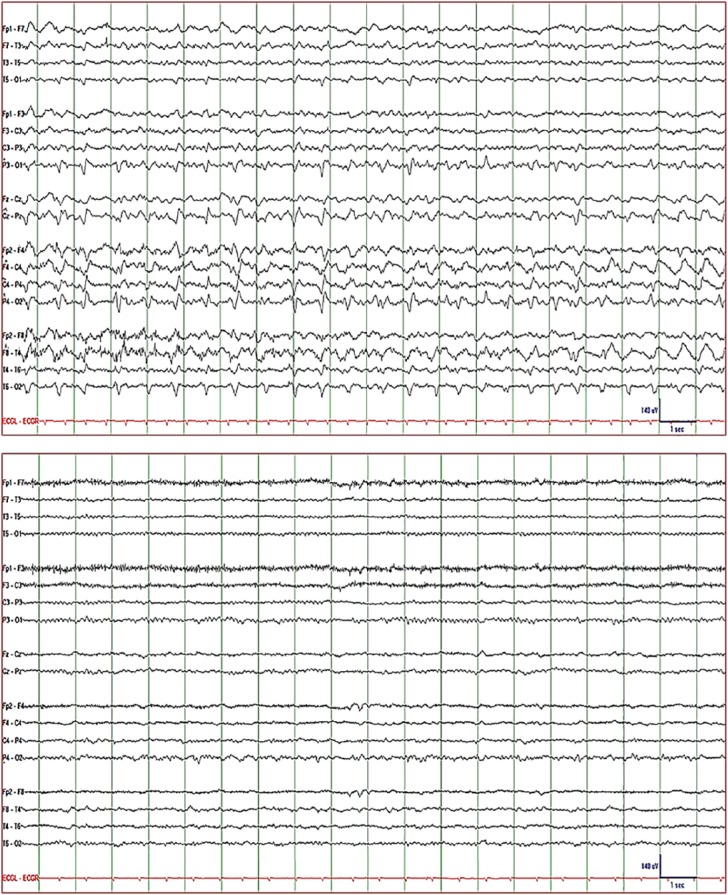
EEG of Patient 3. Top: 0.5 to 1/s lateralized periodic
discharges (sharp/delta waves) with maximum voltage over the right
frontocentral superimposed on irregular slow waves and time-locked to the
myoclonic jerks of the left face, arm, and leg consistent with epilepsia
partialis continua. Bottom: electrographic (and clinical as
seen on video) resolution of epilepsia partialis continua 3 days after
dexamethasone was added to conventional antiepileptic regimen.
Display parameters: longitudinal bipolar montage (from
top to bottom: left-mid-right-ECG), digital filter bandpass of 1 to70 Hz,
and 60-Hz notch filter turned on; voltage-time scale is included in the
tracing.